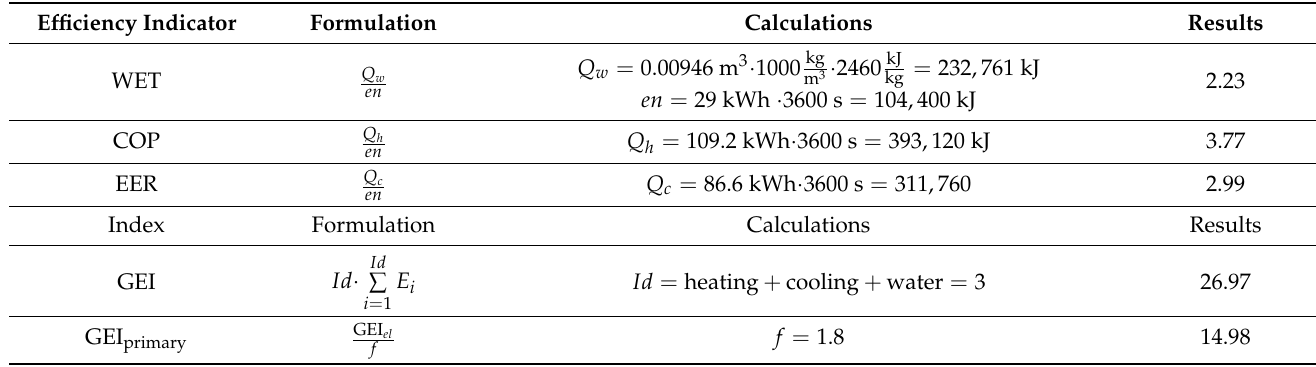
Table 3. GEI results for the integrated